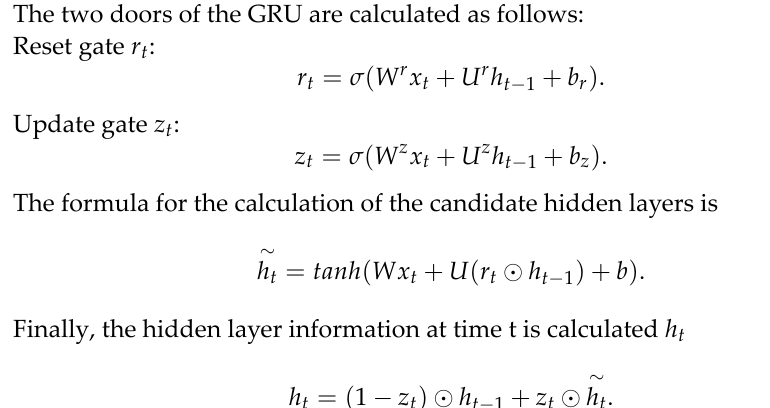
Figure 4. Structure of GRU unit.